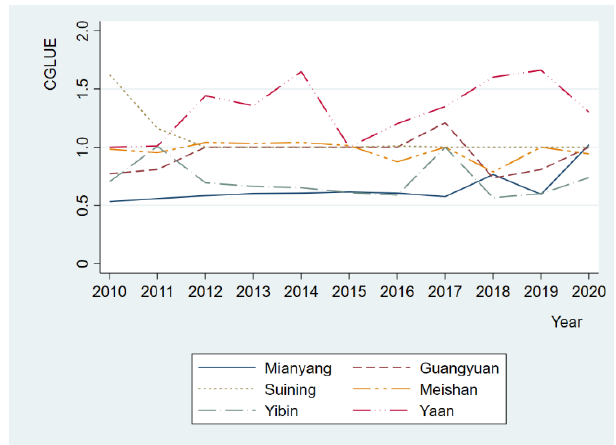
Figure 5. CGLUE results in Chengdu, Zigong, Panzhihua, Luzhou, and Deyang.